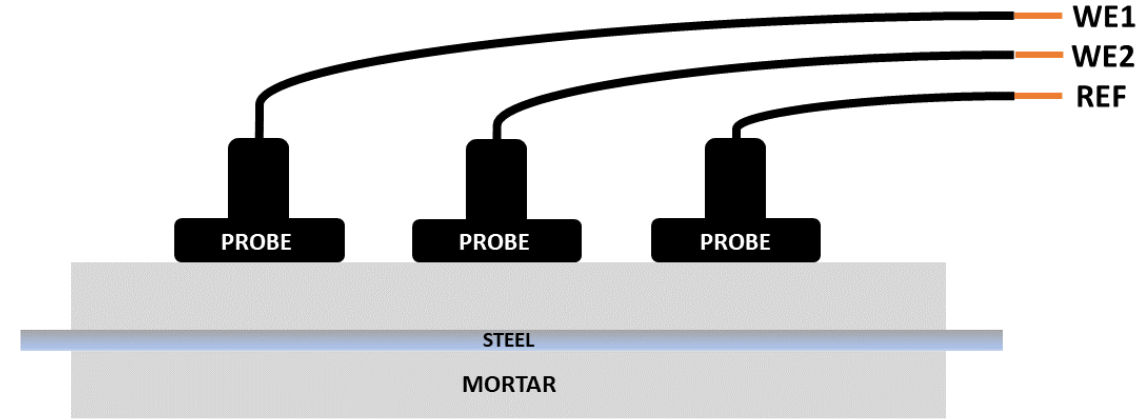
Figure 6. Schematic of no connection to substrate (NOCS) arrangement for ENM measurement.